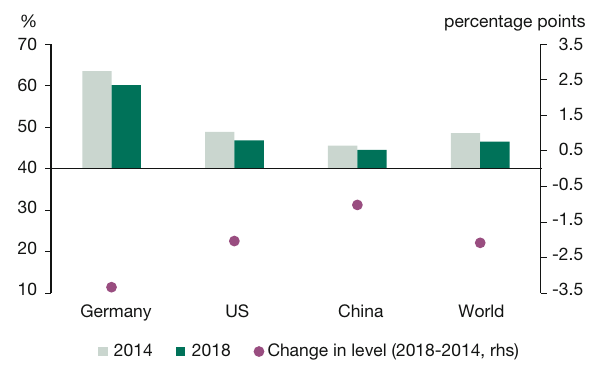
Global value chain participation in selected